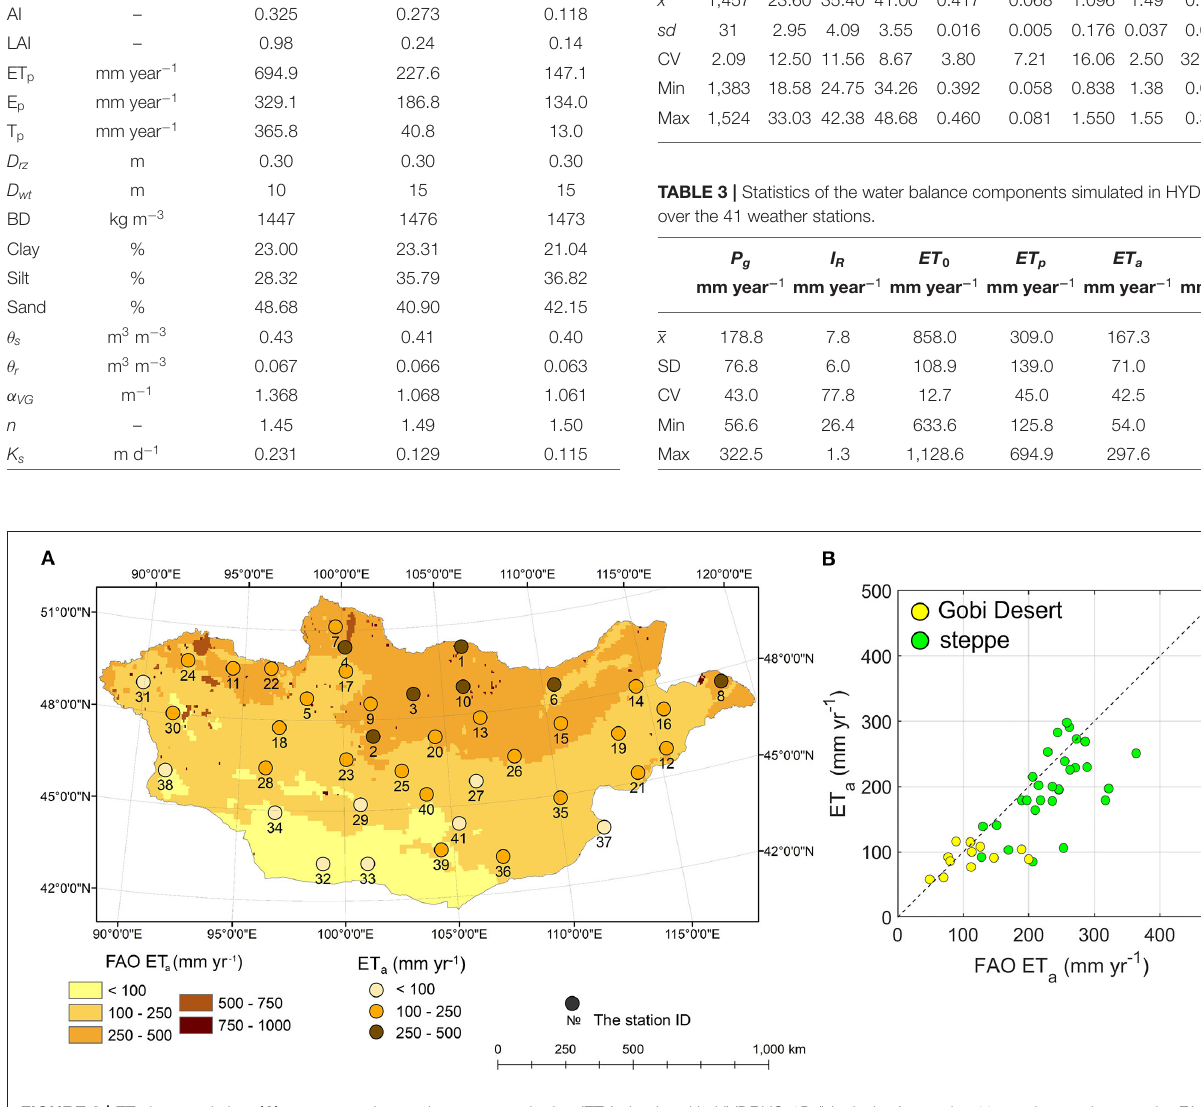
FIGURE 3 | ET characteristics: (A) mean actual annual evapotranspiration (ET a ) simulated in HYDRUS-1D (black dots) over the 41 weather stations on the FAO map; and (B) comparison between ET a values reported in the FAO map (FAO ET a ) and ET a values simulated in HYDRUS-1D (ET a ). Green and yellow circles indicate the steppe region and Gobi Desert, respectively.